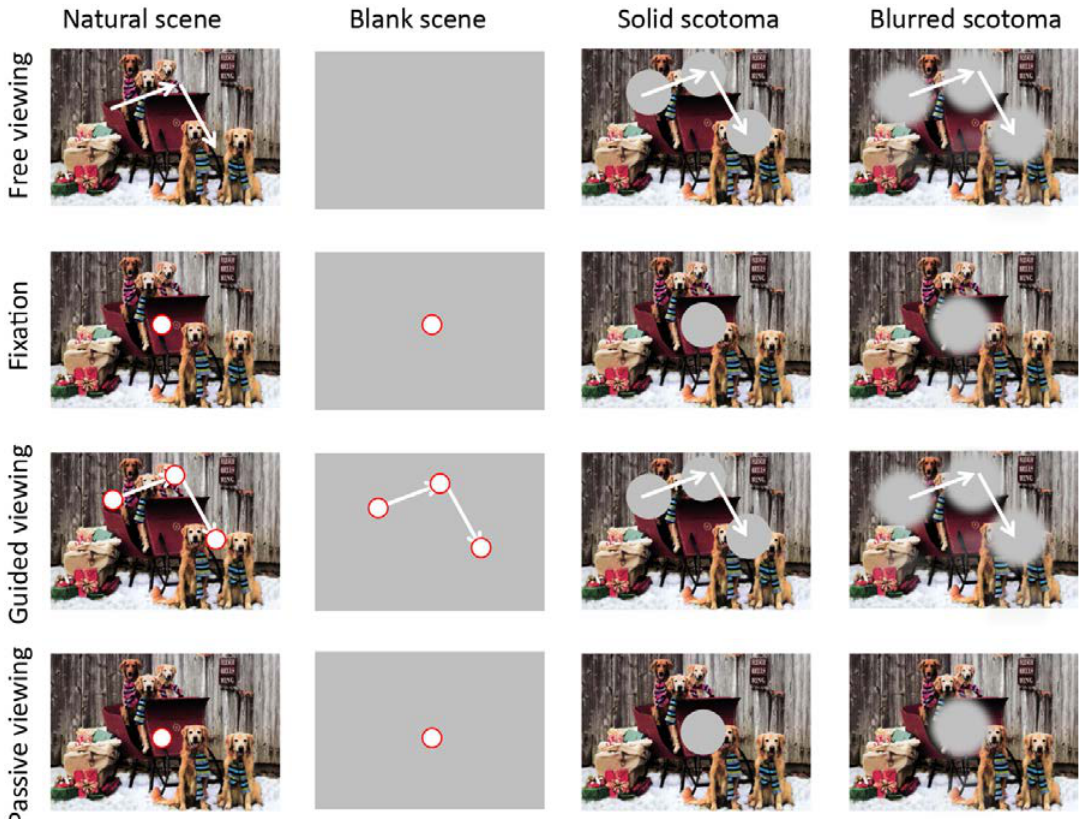
Figure 1. Experimental conditions. The experiments included four viewing conditions (free viewing, fixation, guided viewing, passive viewing) and four scene conditions (natural scene, blank scene, solid scotoma, blurred scotoma). The natural-scene and blank-scene conditions displayed central fixation targets in all viewing conditions, except for the free-viewing condition. In the guided-viewing condition, the fixation target—or the scotoma, when present—moved, replaying the eye movements previously recorded in the free- viewing condition. In the passive-viewing condition, the background moved, replaying the eye movements previously recorded in the free-viewing condition. In the free-viewing scotoma conditions, solid or blurred gaze-contingent scotomas were presented at each fixation location. Fixation targets and scotomas are depicted for illustration purposes, and not to